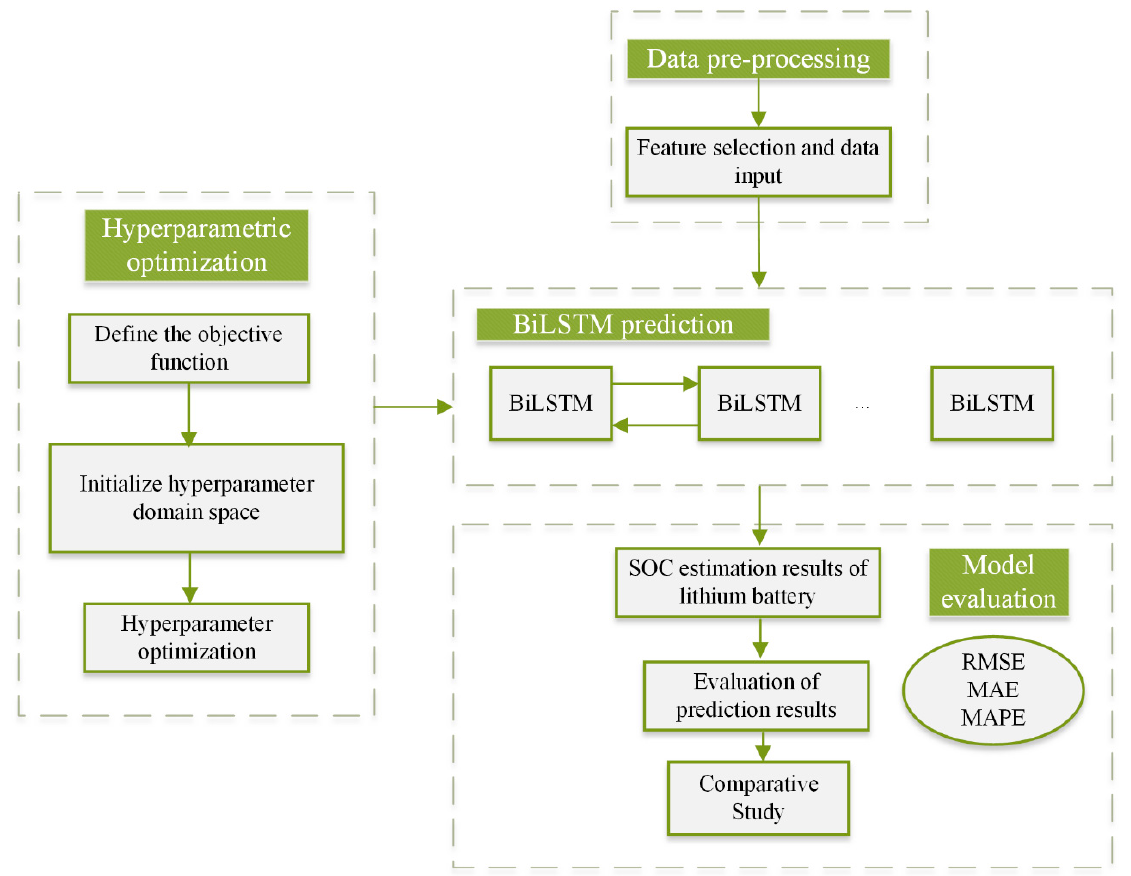
Figure 3. Bayes-BiLSTM model structure.